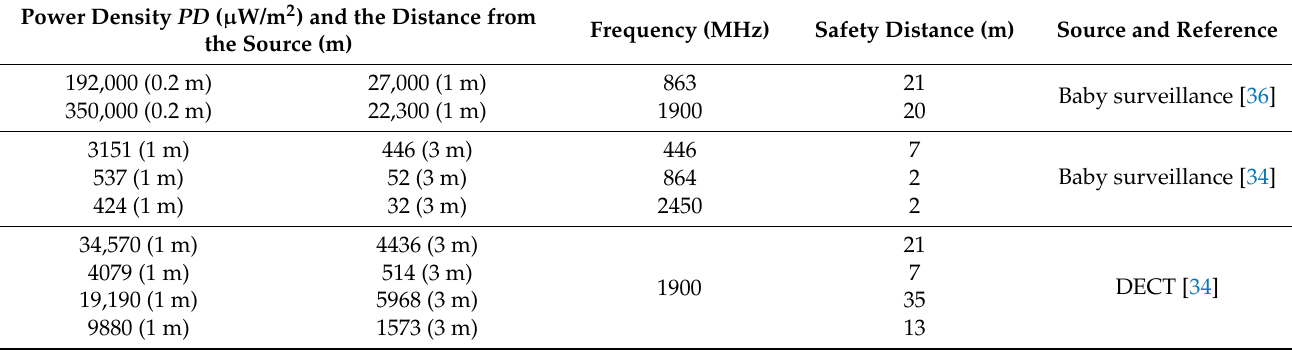
Table 5. Attenuation of the power density PD ( µ W/m 2 ) according to the distance between the source and the animal. A safety distance was determined in order to reduce the power density to PD = 100 µ W/m 2 , which was assumed to be a typical value for ambient exposure. For the DECT devices, four units were measured. Power Density PD ( µ W/m 2 ) and the Distance